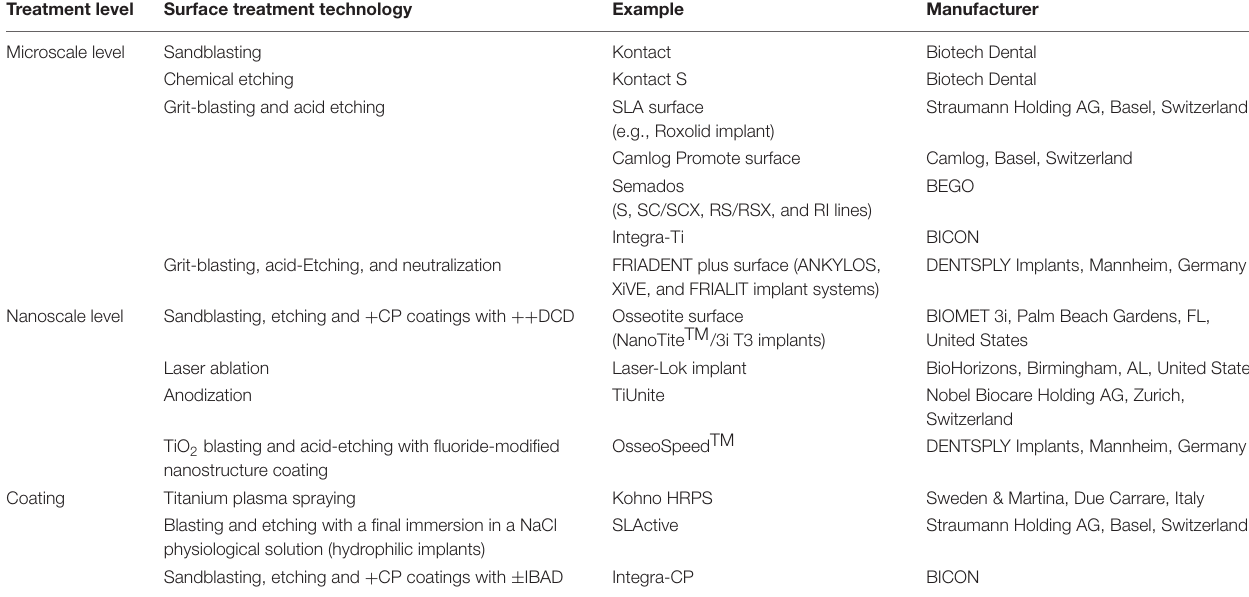
TABLE 1 | Surface treatment techniques with some current commercial